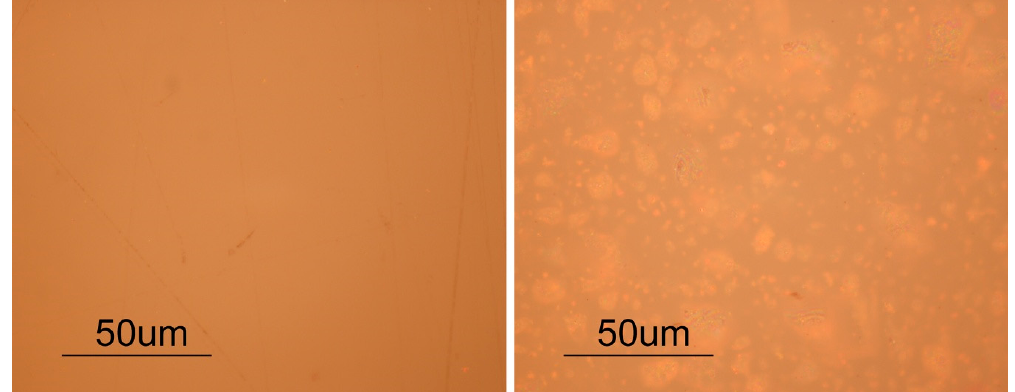
Figure 2. OM images of the two surfaces of RAL acquired under reflected light, bright field, at 500× original magnification. Images show that the two surfaces of the sheet are not similar, one having more accumulation of pigment agglomerates than the other. The sedimentation of the pigment might be an indication that polymerization of the PMMA sheets was conducted in horizontal position.